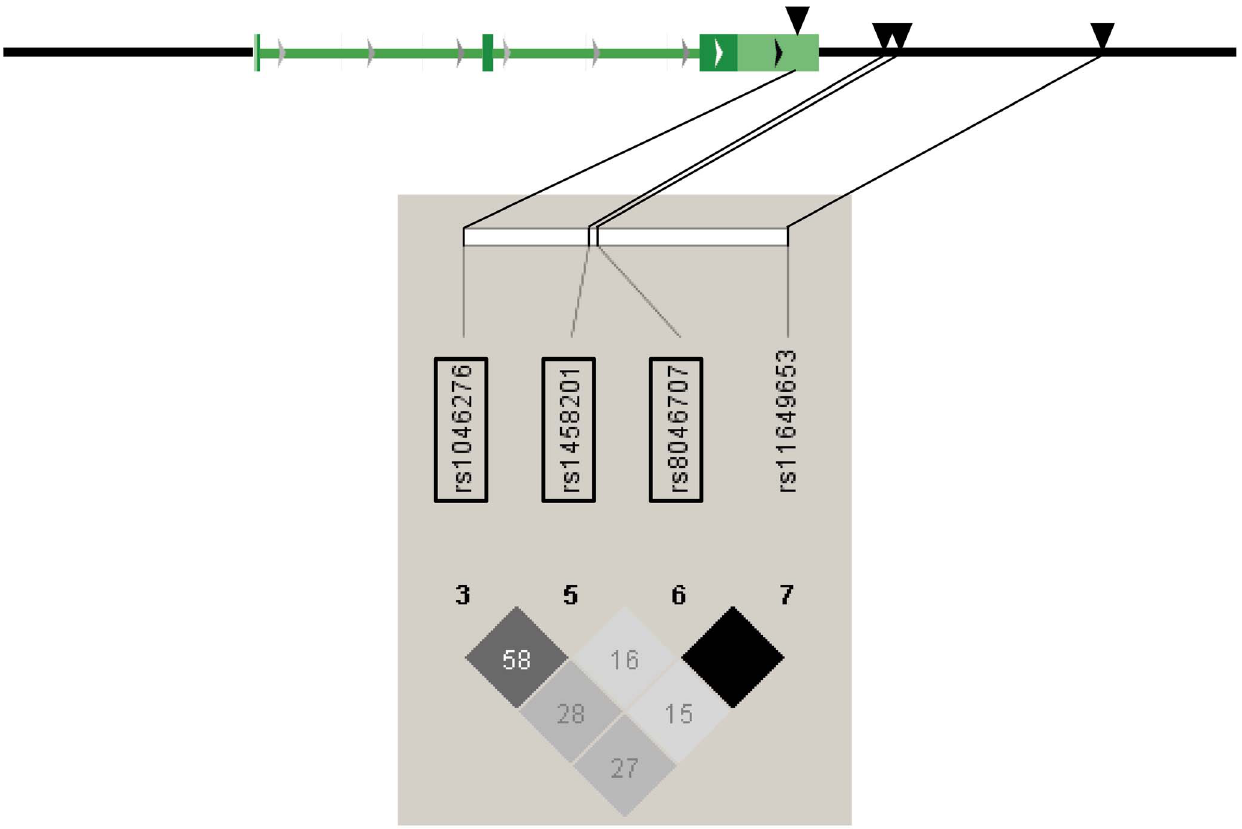
Figure 1. Genomic region of human chromosome 16p11.2 harbouring the CTF1 gene and HapMap linkage disequilibrium (r 2 ) data of common (MAF $ 0.05) informative SNPs within this region. The CTF1 gene consists of three exons and two introns and spans 6.953 kb from nucleotide 30,815,429 to nucleotide 30,822,381 (HapMap coordinates). The analyzed region additionally included 3 kb of the 5 9 -flanking region and 5 kb of the 3 9 -flanking region. The genotyped SNPs are highlighted by black frames. In the diamonds below the SNPs, r 2 values are given (black diamonds: r 2 =1.0).